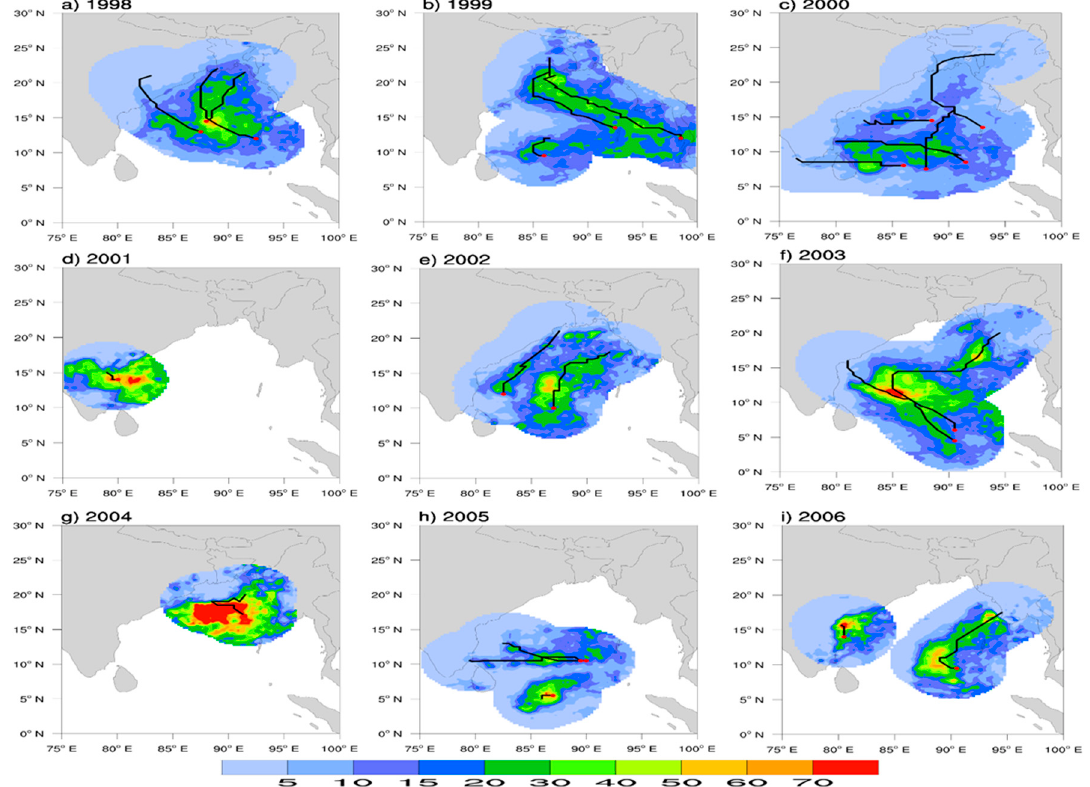
Figure 4. Accumulated TC rainfall (mm) during 1998–2006. The red circle indicates the genesis point of TCs. ( a ) 1998, ( b ) 1999, ( c ) 2000, ( d ) 2001, ( e ) 2002, ( f ) 2003, ( g ) 2004, ( h ) 2005, ( i ) 2006.